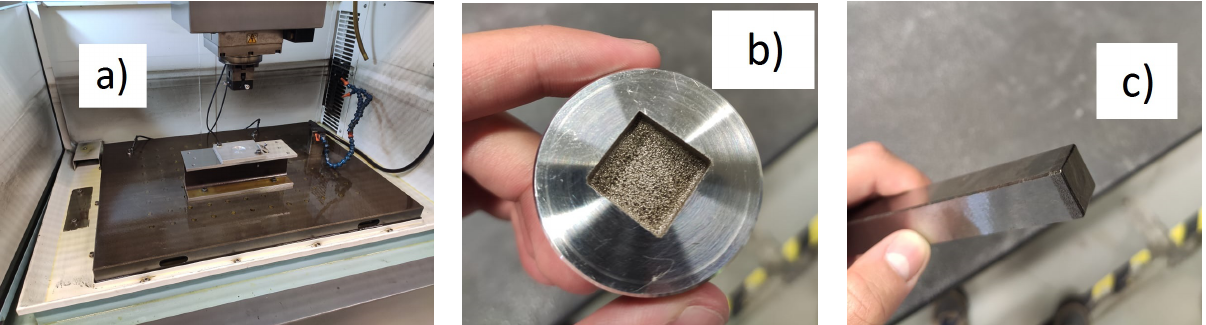
Figure 4. ( a ) EDM machine setup; ( b ) Workpiece; ( c )